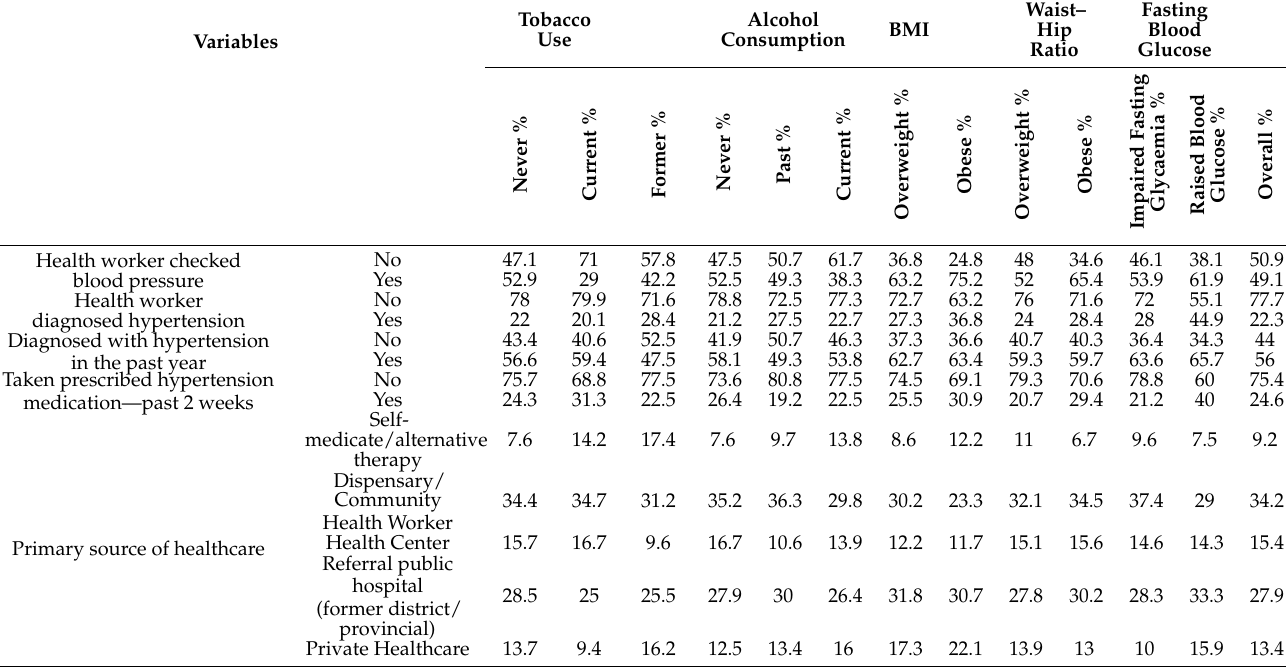
Table 4. Awareness and health utilization among people in the selected hypertension risk